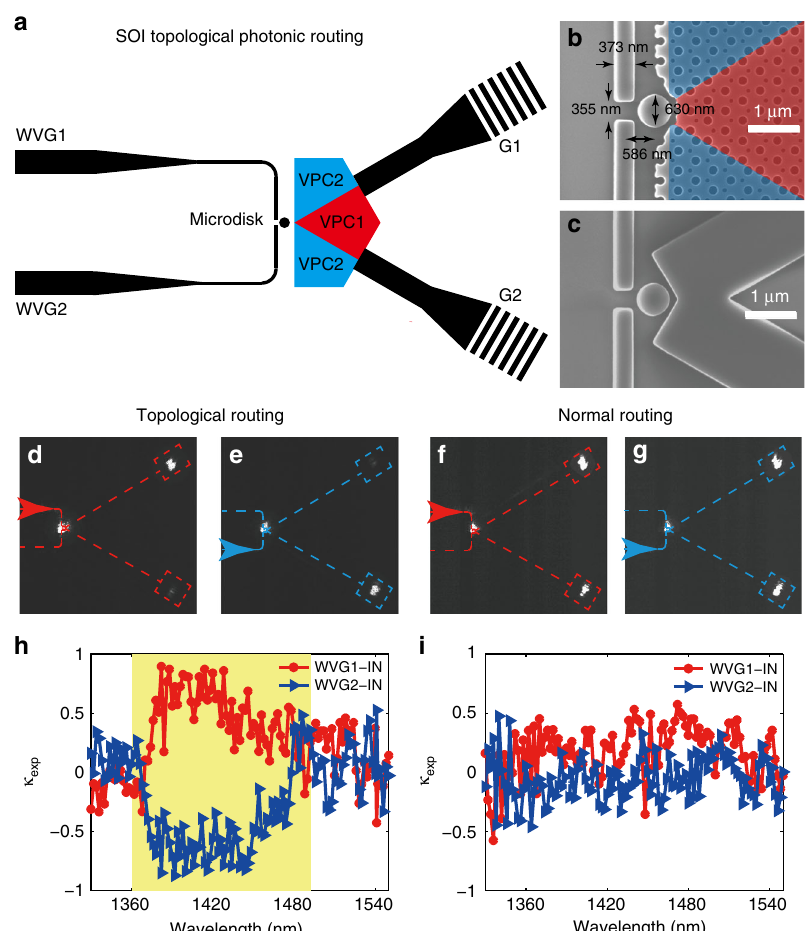
Fig. 4 Experimental realization of topological photonic routing. a Schematic view of a topological photonic routing sample, including the valley photonic crystal (VPC) interface and the microdisk. The incident light from WVG1/WVG2 will excite an anticlockwise/clockwise phase vortex in the microdisk and then couple to the upper/lower interface in support of the different valley – chirality-locked modes. The light will fi nally couple back to free space by a nonuniform grating coupler (G1 and G2). b Scanning-electron-microscope image of the sample near a microdisk. The width of the input waveguide is w wvg = 373 nm, and the air gap in the waveguide is w gap = 355 nm. The diameter of microdisk d m = 630 nm, with its distance to the center of the waveguide h = 586nm. c Control sample with the same con fi guration to b , except for replacing the VPC interfaces by two-strip silicon waveguides. d – g , Measurement of photonic routing pro fi les at λ = 1400 nm, imaged by an optical far- fi eld microscopy (20× objective). For topological routing ( d , e ), the incident light from the WVG1 port was routed to the upper interface, while another case from the WVG2 port was reversed. For normal routing ( f , g ), the light energy splits almost equally into two ports. h – i , Measured directionality spectra for topological ( h ) and normal ( i ) photonic routing devices. The spectra show the directional coupling ef fi ciency, κ exp = ( I G1 – I G2 )/( I G1 + I G2 ), as a function of the operation wavelength. Here, I G1 and I G2 are the extracted intensities collected from G1 and G2. For both WVG1 (red) and WVG2 (blue) incident case, the directional coupling ef fi ciency of the topological routing device is beyond the value of 0.5 within a broadband region, some of which is close to unity. i For comparison, the normal routing device has